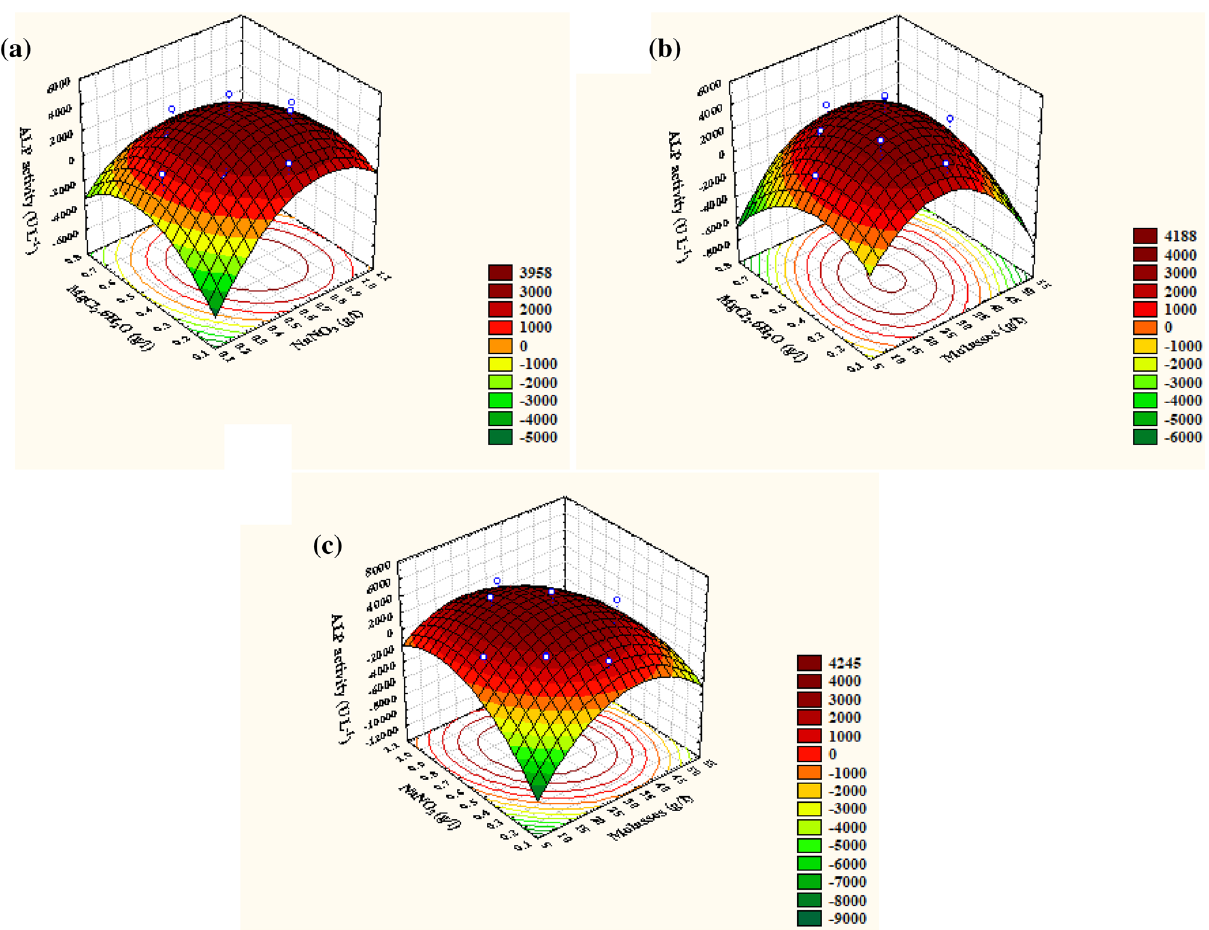
2 ·6H 2 O, and (c) interaction between molasses and NaNO 3